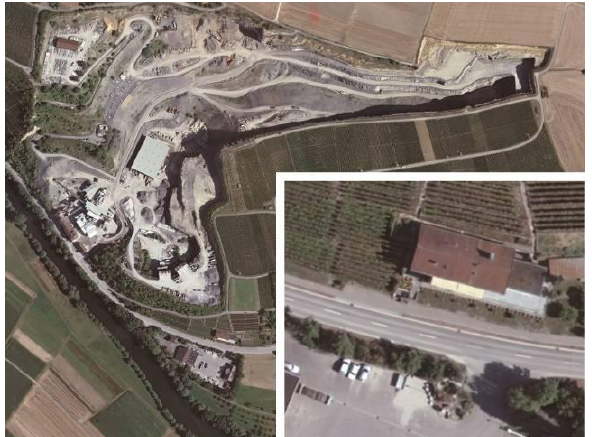
Figure 9: Ortho image from DMC (flown August 2008).